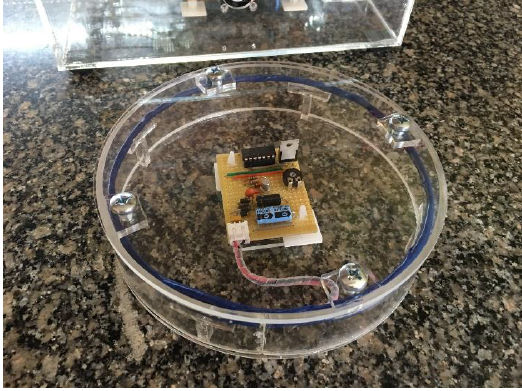
Figure 8. The circular coil RFID transponder.